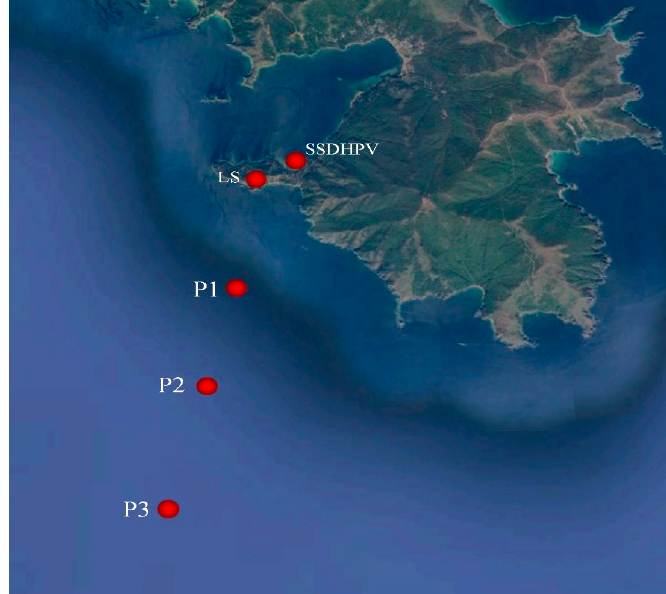
13 of 16 Figure 14. Dynamic spectrogram of the record of the supersensitive detector of hydrosphere pressure variations, obtained in the process of recording signals of various complexity, generated by a low-frequency hydroacoustic emitter with carrier frequency of 245 Hz. In the summer of 2019, we researched the regularities of low-frequency hydroacoustic signals propagation from the open sea to a semi-closed bay through the land part of Shultz Cape. Generation of low-frequency harmonic signals was made using two hydroacoustic emitters of the